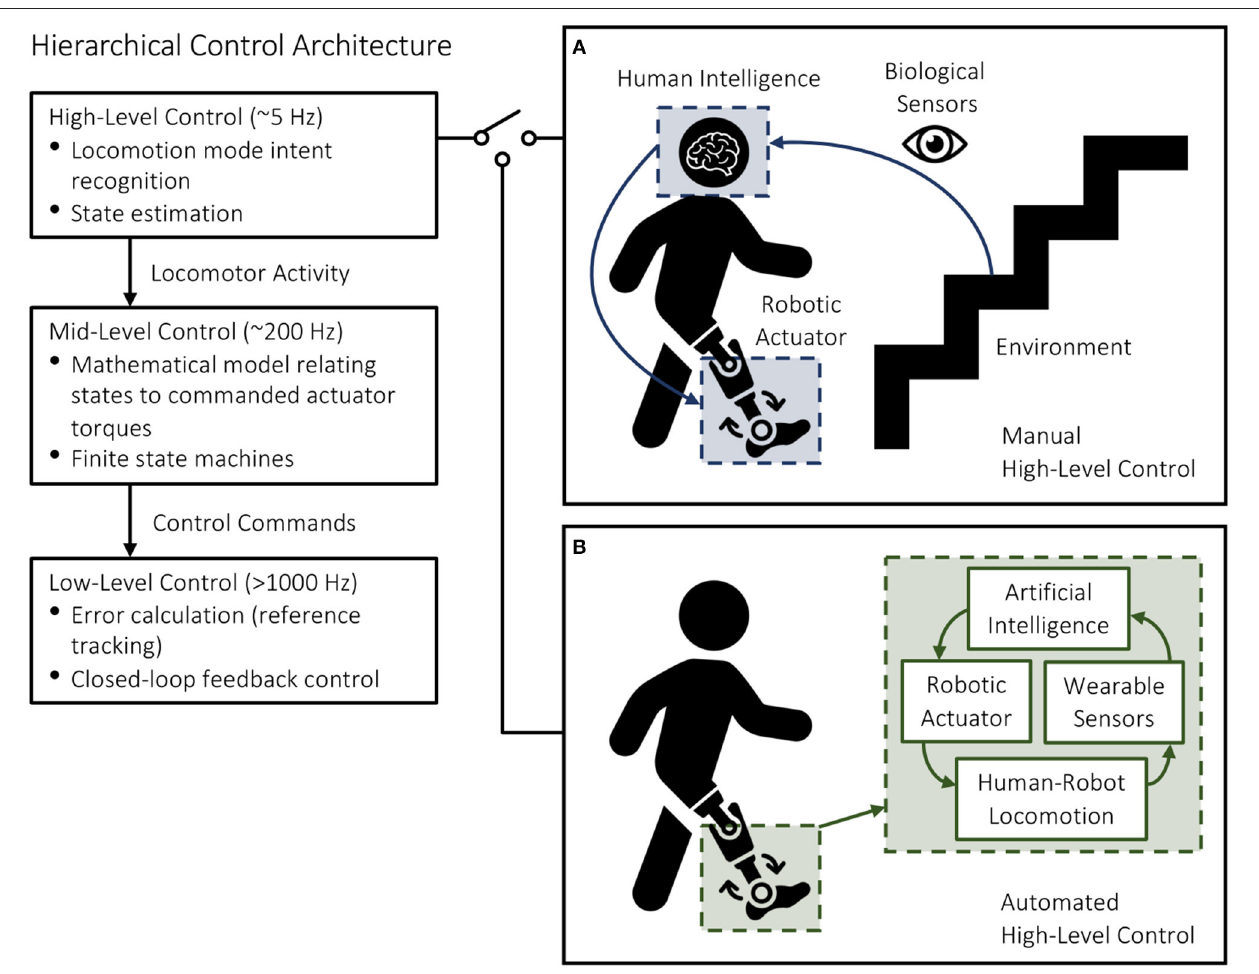
FIGURE 1 | Hierarchical control architecture of robotic leg prostheses and exoskeletons, including high, mid, and low-level controllers. The high-level controller selects the desired locomotion mode using either (A) manual communication from the user (i.e., for commercially available devices) or (B) automated systems (i.e., for devices under research and